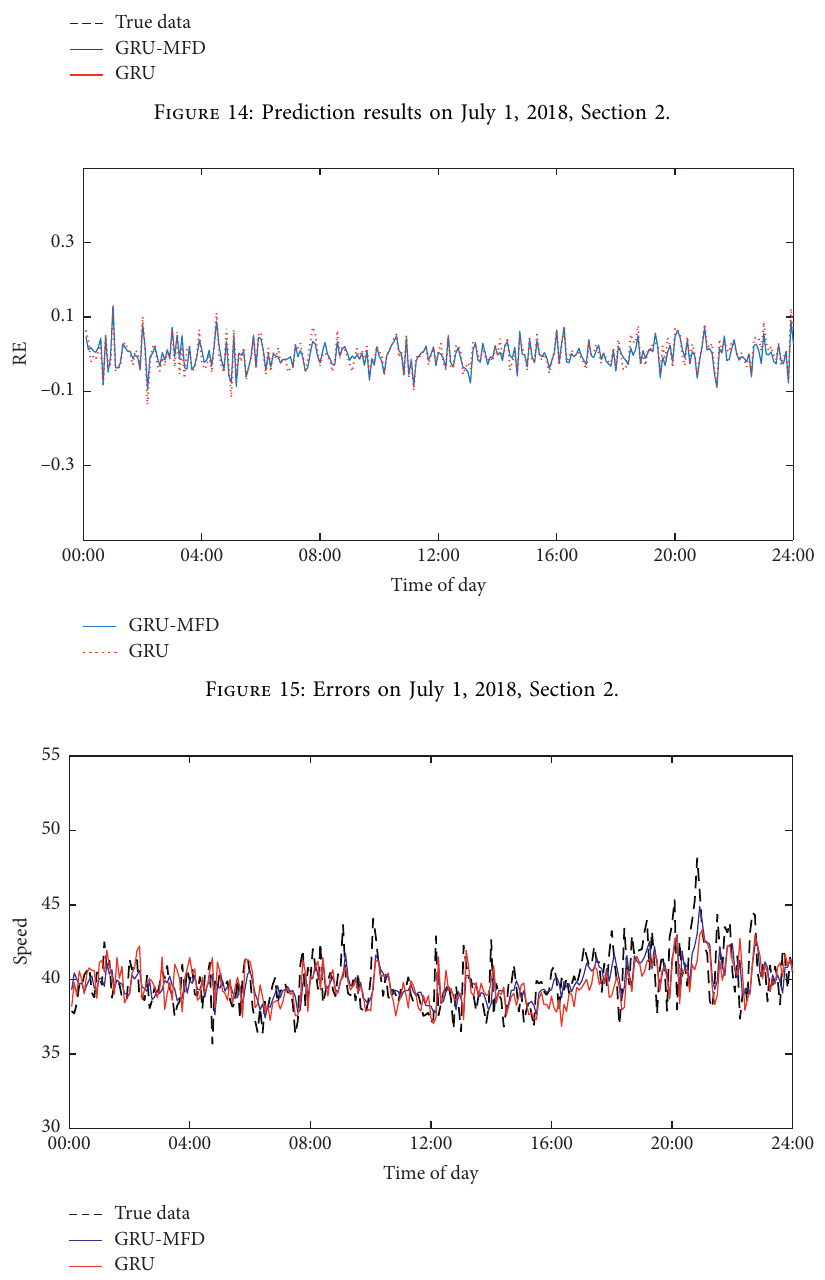
Figure 16: Prediction results on July 5, 2018, Section